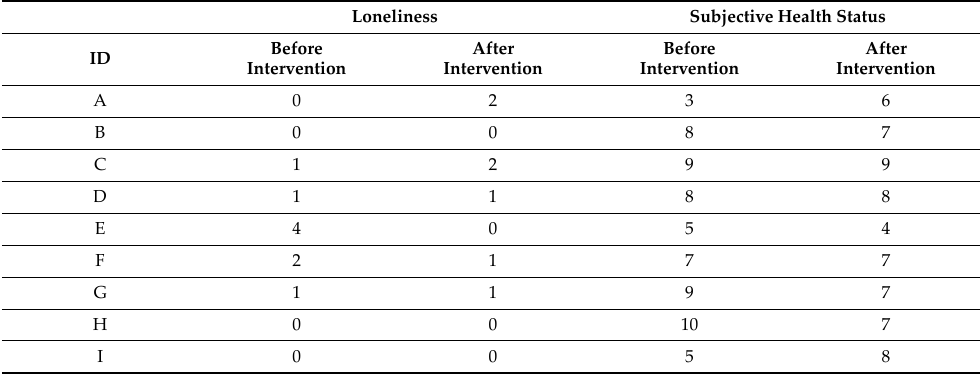
Table 4. Participants’ loneliness scores and subjective health